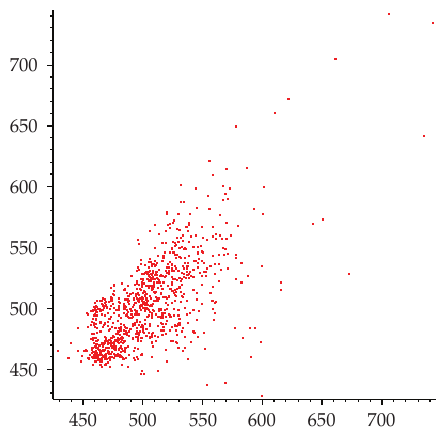
Figure 8: (cid:2) y (cid:2) t − 1 (cid:3) ,y (cid:2) t (cid:3)(cid:3) in the stochastic case for d (cid:7) 0 . 6.